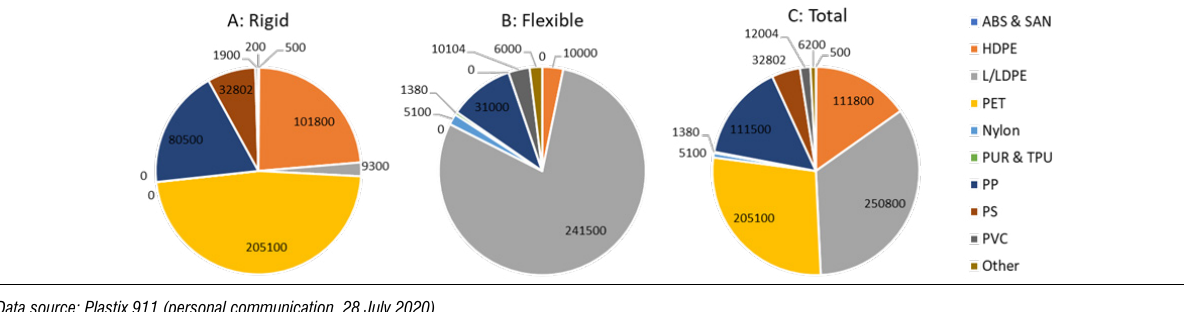
Figure 2: Quantities of plastics manufactured in South Africa in 2019 (all figures in metric tons per